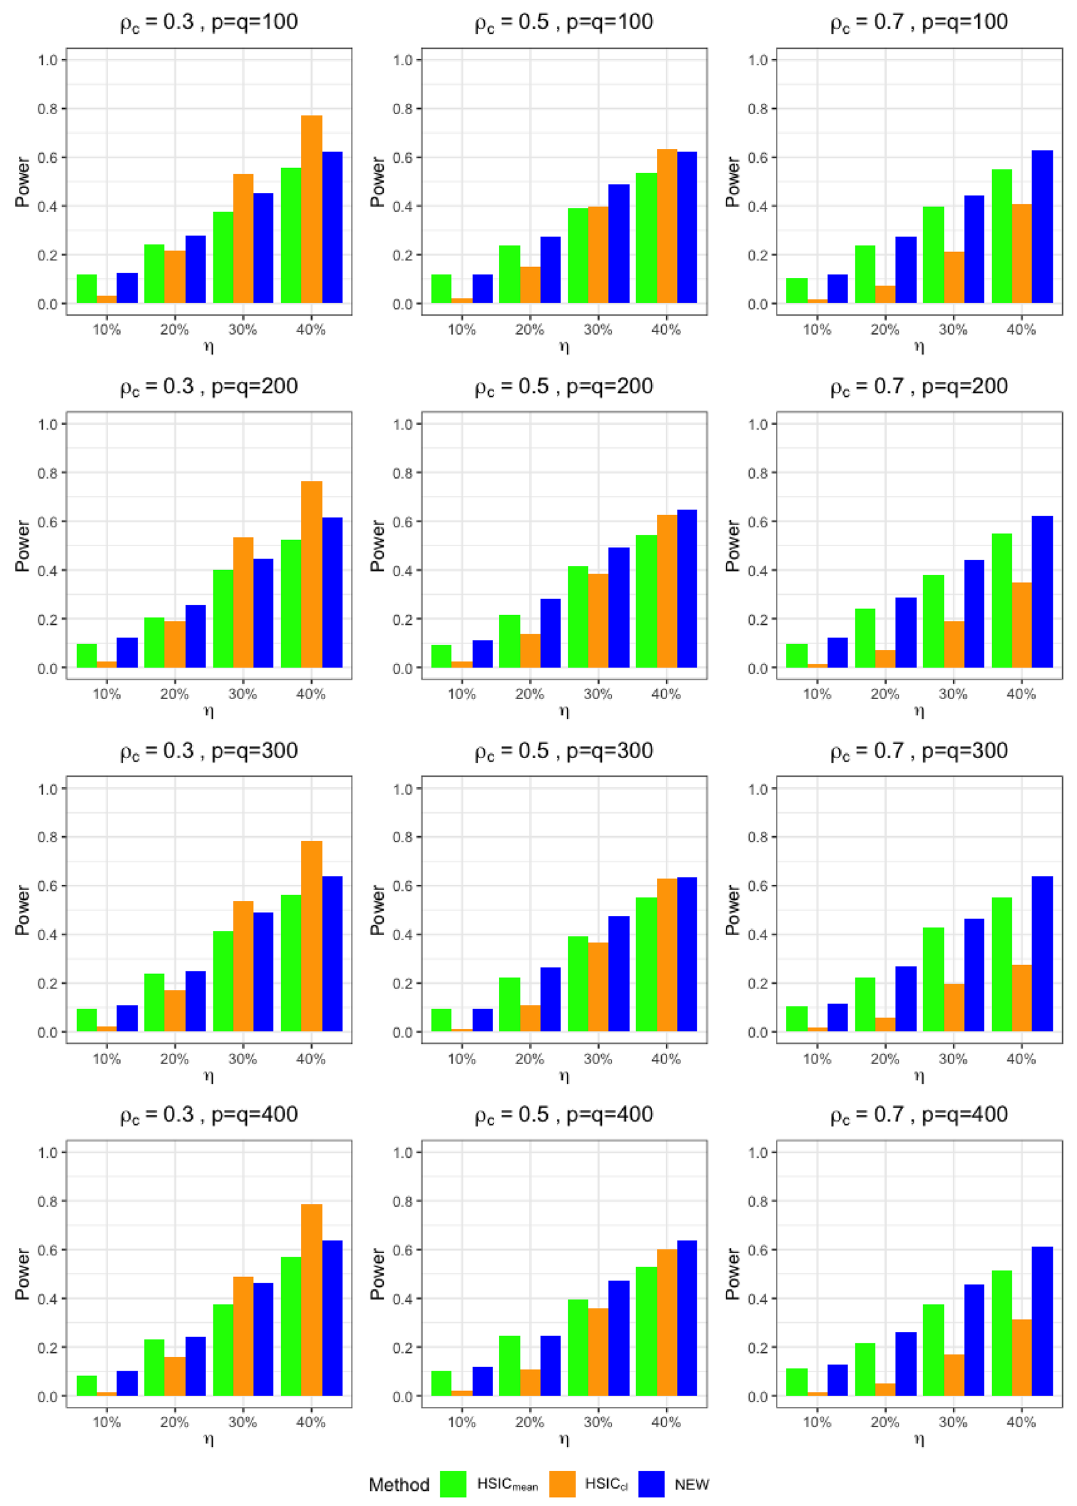
Figure 2. Estimated power of the tests under different exposures (η) , within-cluster correlations (ρ c ) , and dimensions p = q when m = 100